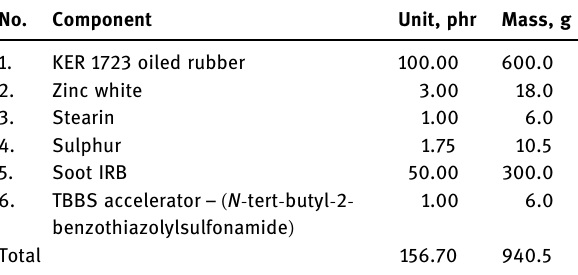
Table 9: Composition of rubber compound based on the